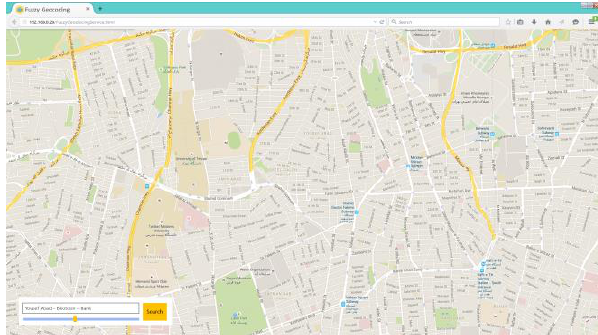
Figure 5. User Interface of Web-based Geocoding